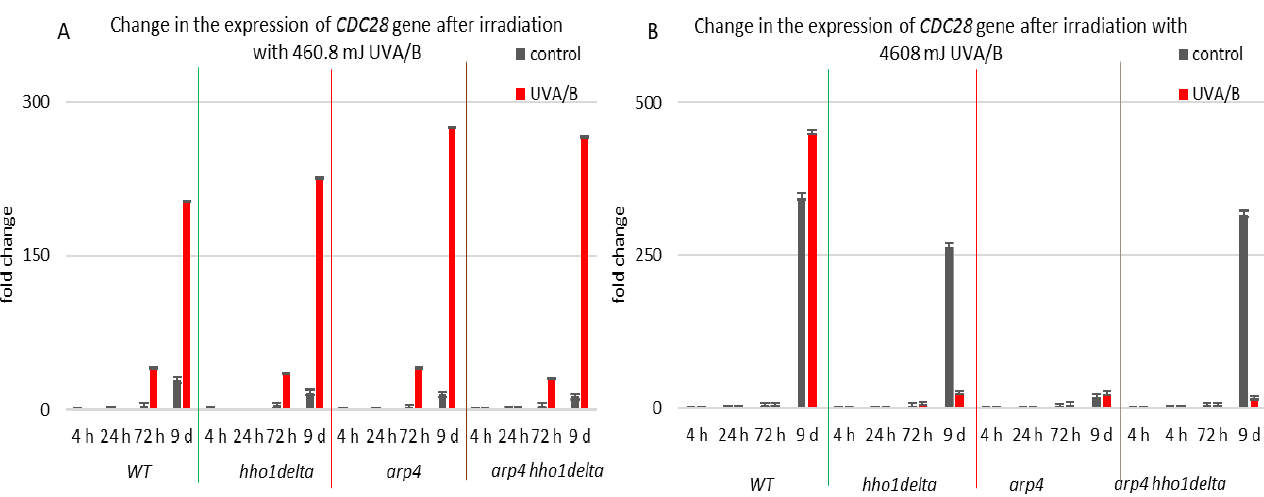
Figure 9. Change in the expression of CDC28 gene after UVA/B irradiation. ( A ) 3 min (460.8 mJ). ( B ) 30 min (4608 mJ). Three repetitions of the experiment are done and results are MEAN fold change ± STDV.